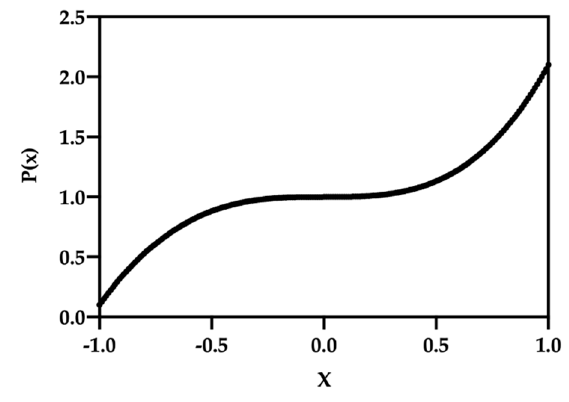
Figure 7. The curve of the penalty function.